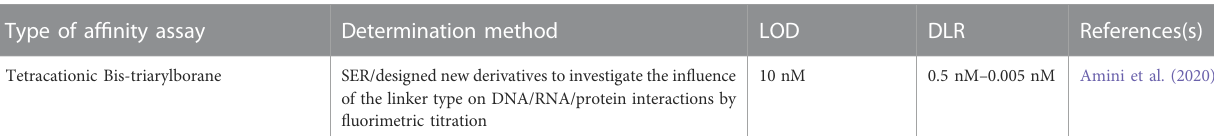
optical sensor has been summarized in the fl ow chart.